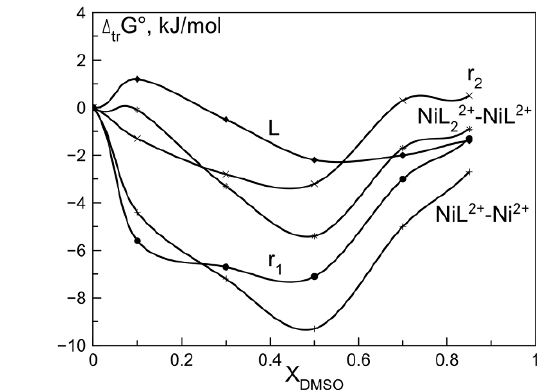
Figure 2. Gibbs energy changes of reaction and reagents transfer of nickel(II) complexation with nicotinamide from water to aqueous dimethyl sulfoxide (m. f.).